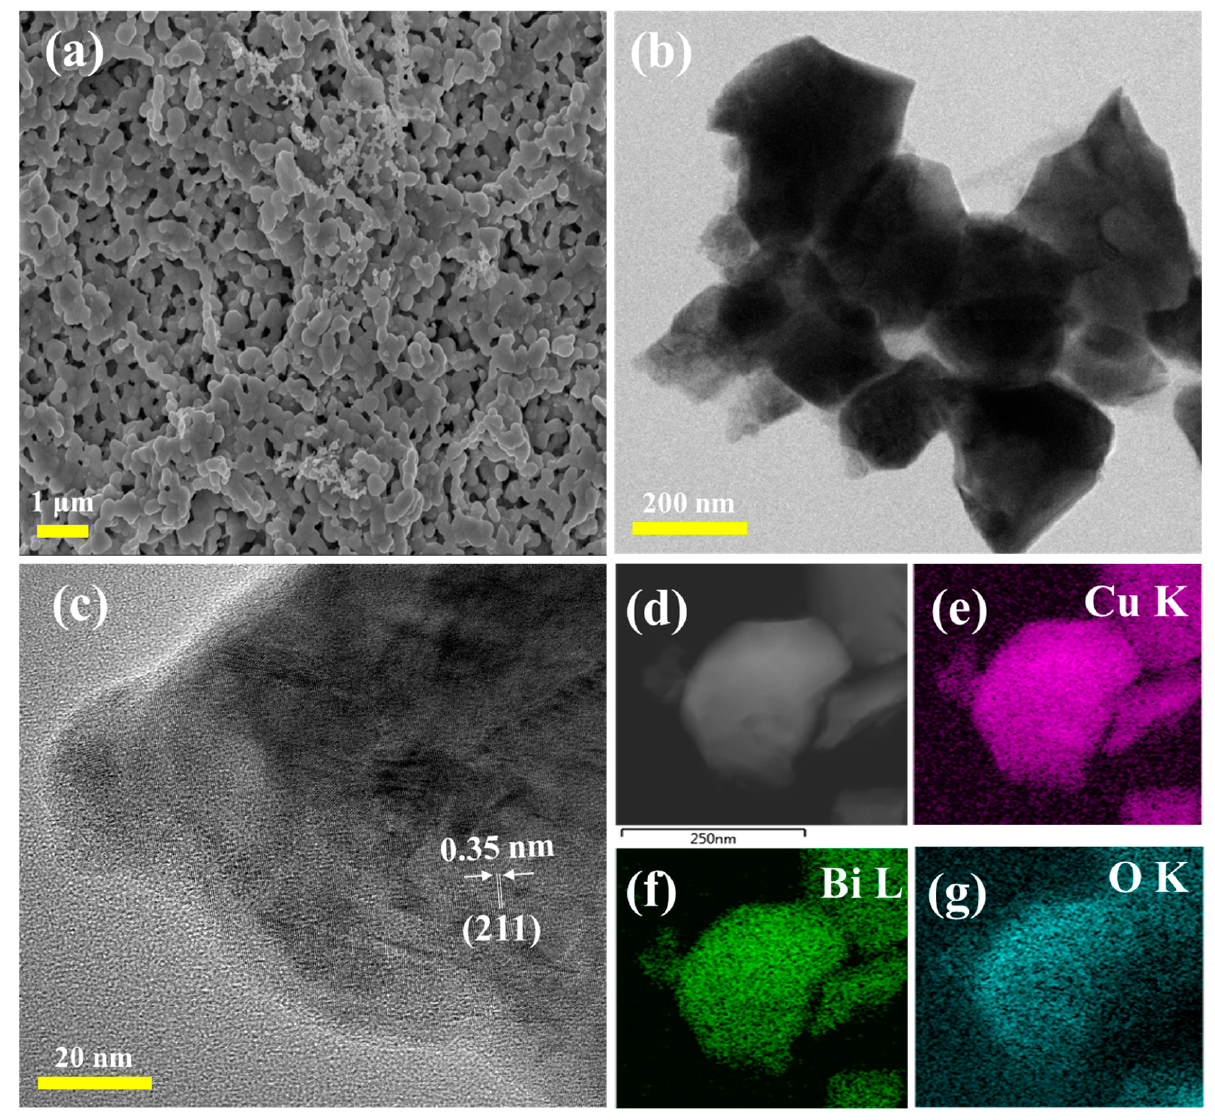
Figure 2. ( a ) SEM result, ( b ) TEM results, ( c ) HRTEM image of #2-CuBi 2 O 4 , and ( d – g ) TEM–EDS analysis of the #2-CuBi 2 O 4 photocathode.